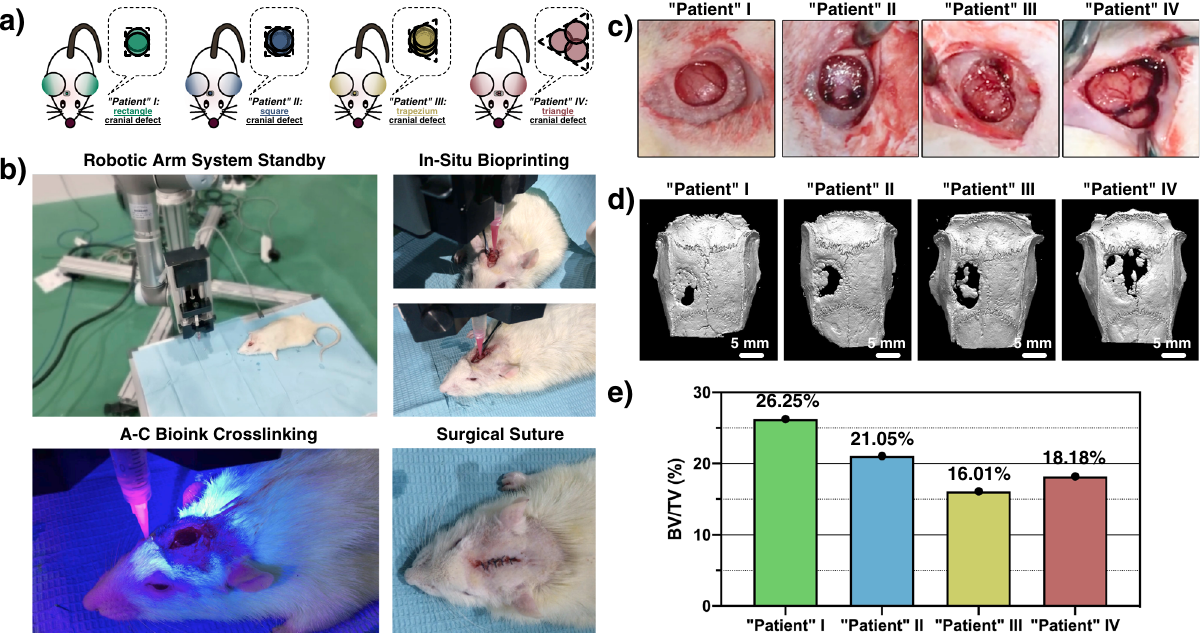
Fig. 8 In-situ bioprinting at rat cranial defect models with different morphology with A – C bioink. a 3D structure morphologies of the rat cranial defect models. b In-situ bioprinting steps with A – C bioink. c Original "patient" cranial defect morphology. d Micro-computed tomography examination after 6-week in-situ treatment. e BV/TV value after 6-week in-situ